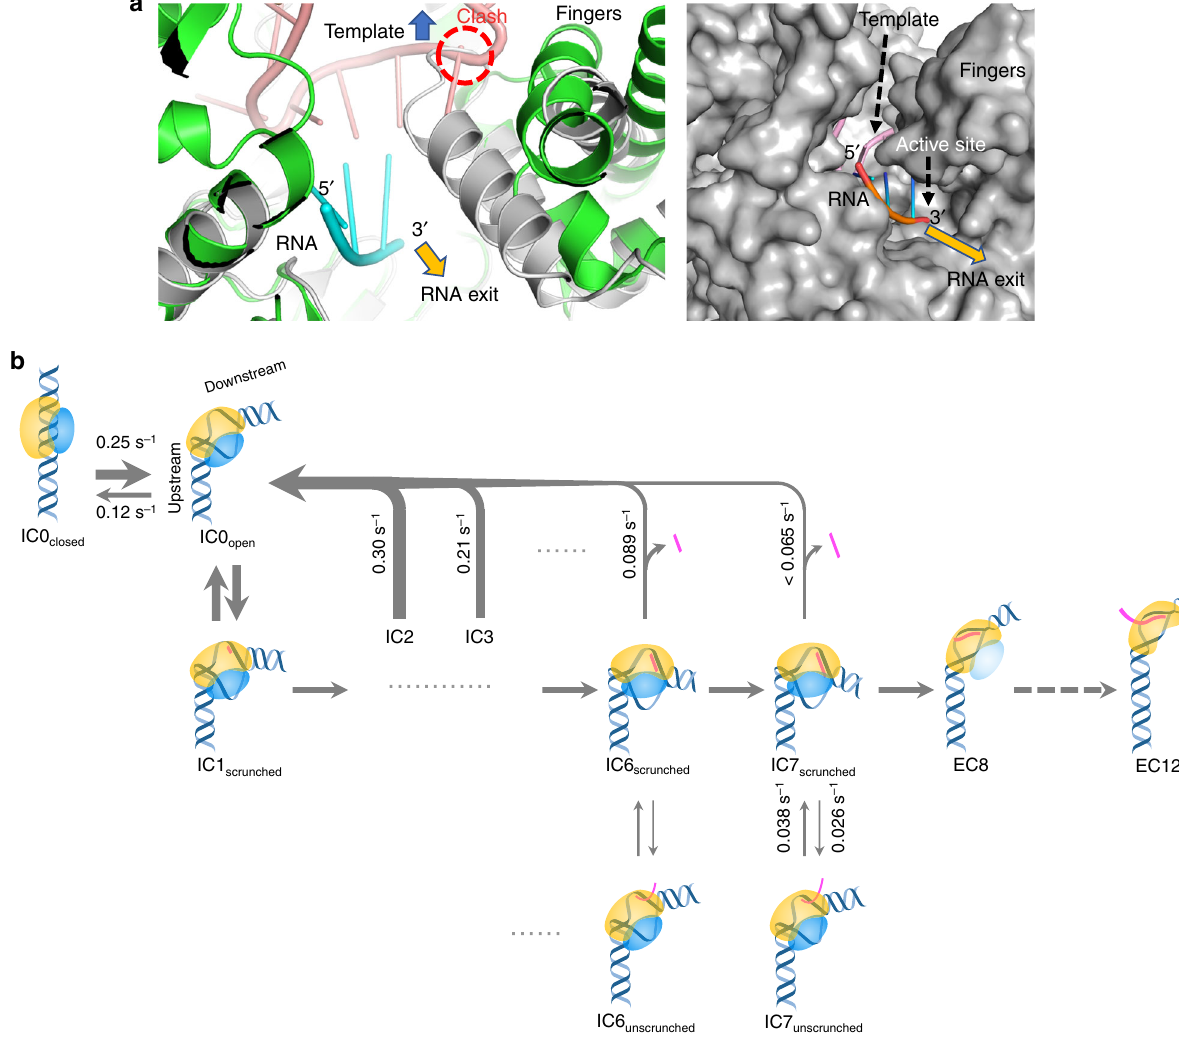
Fig. 7 Structural analysis and kinetic model of mitochondrial transcription initiation. a (Left) superposition of T7 RNAP TIC (PDB Id. 1QLN; green RNAP, pink DNA template, and cyan RNA transcript) on POLRMT from the human mitochondrial TIC structure (PDB Id. 6ERQ; gray POLRMT). (Right) a molecular surface representation of POLRMT showing a possible exit channel (gold arrow) for the 3 ′ -end of RNA. b Conformational states and their transition rates identi fi ed in this study are integrated into a schematic model. Existence of Mtf1 in EC8 is not known yet and thus expressed semitransparent. DNA/RNA oligos and proteins are drawn as in Fig.